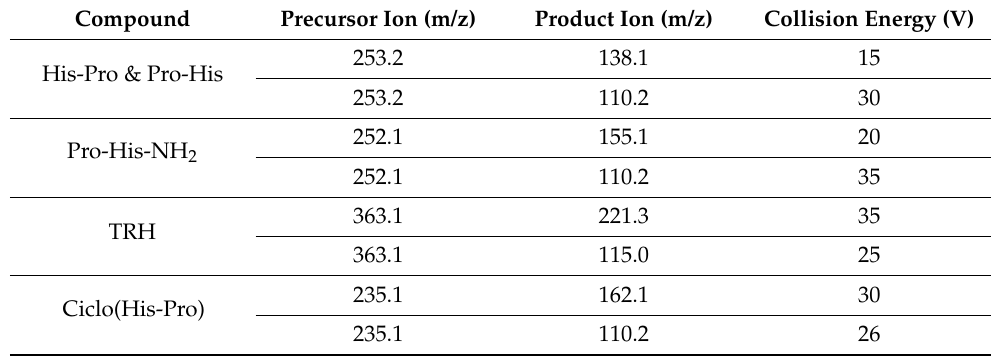
Table 1. MRM transition